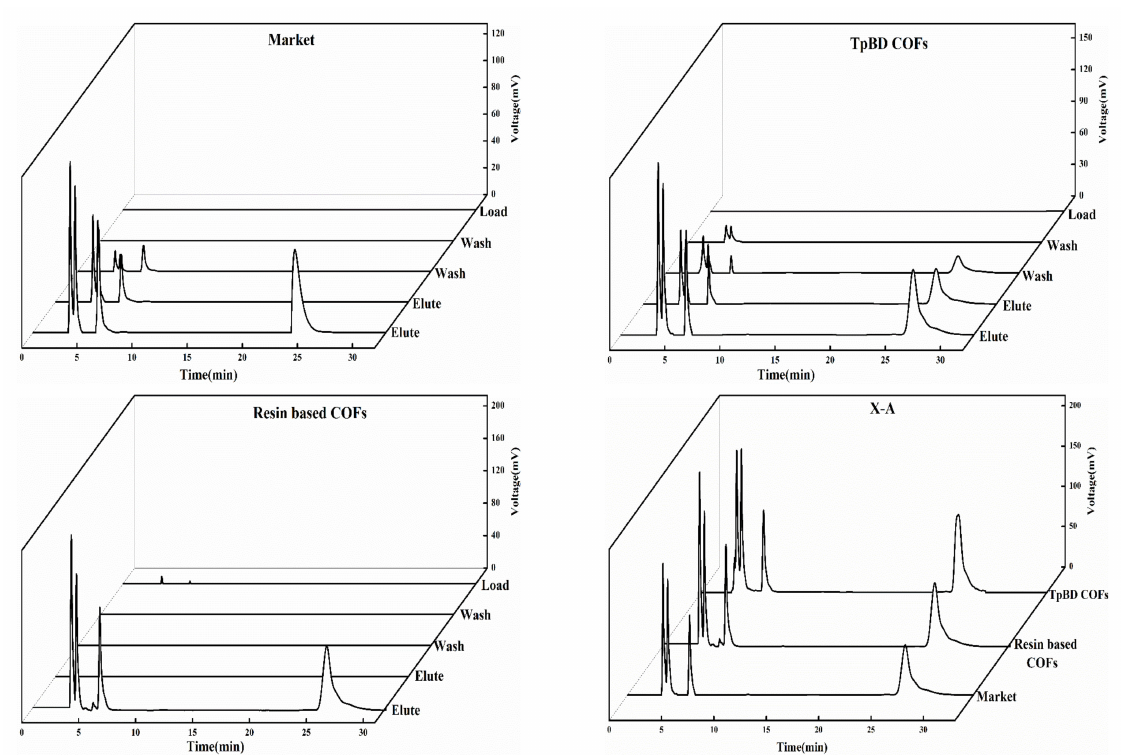
Figure 7. Outflow curves using the X-A